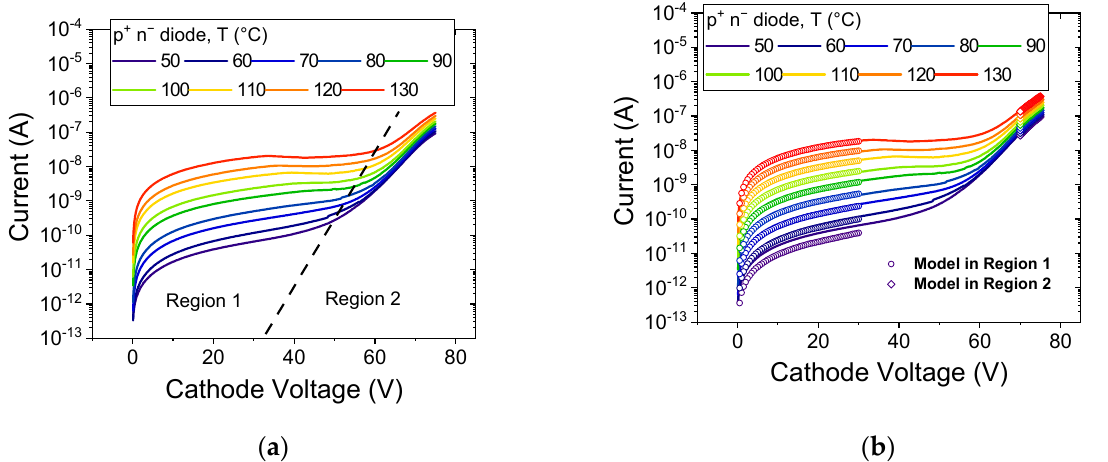
Figure 2. ( a ) Reverse leakage of the p + n − n diodes measured for T = 50 °C to 130 °C. Two distinct regions can be identified; ( b ) illustrates the fit to the models used to describe the leakage evolutions in the two regions.